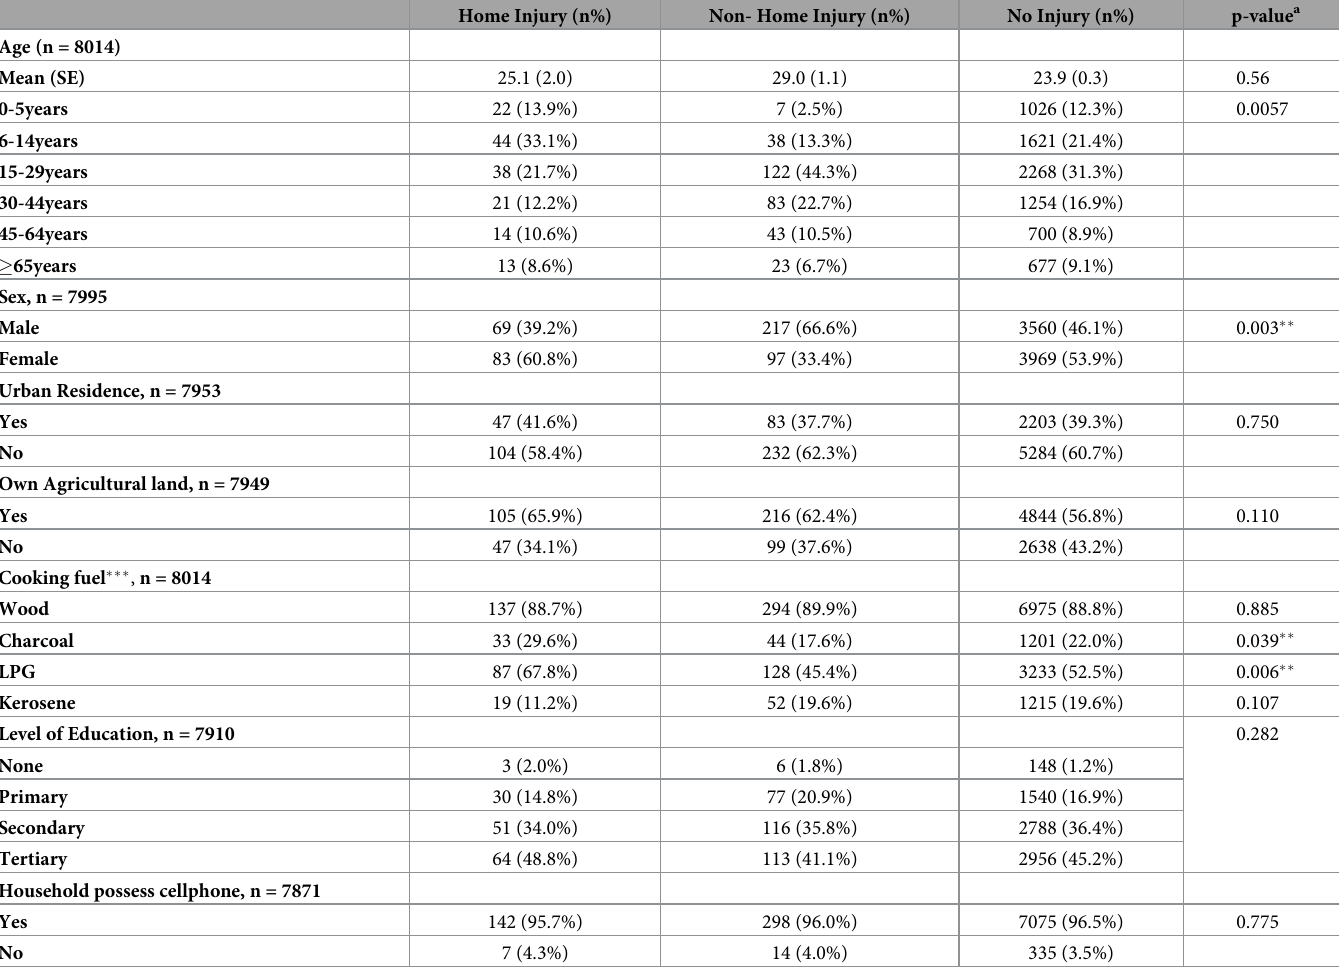
Table 1. Comparison of demographic and socioeconomic variables between individuals with home injury, non- home injury, and the non-injured population (N = 8065 � ) † . Home Injury